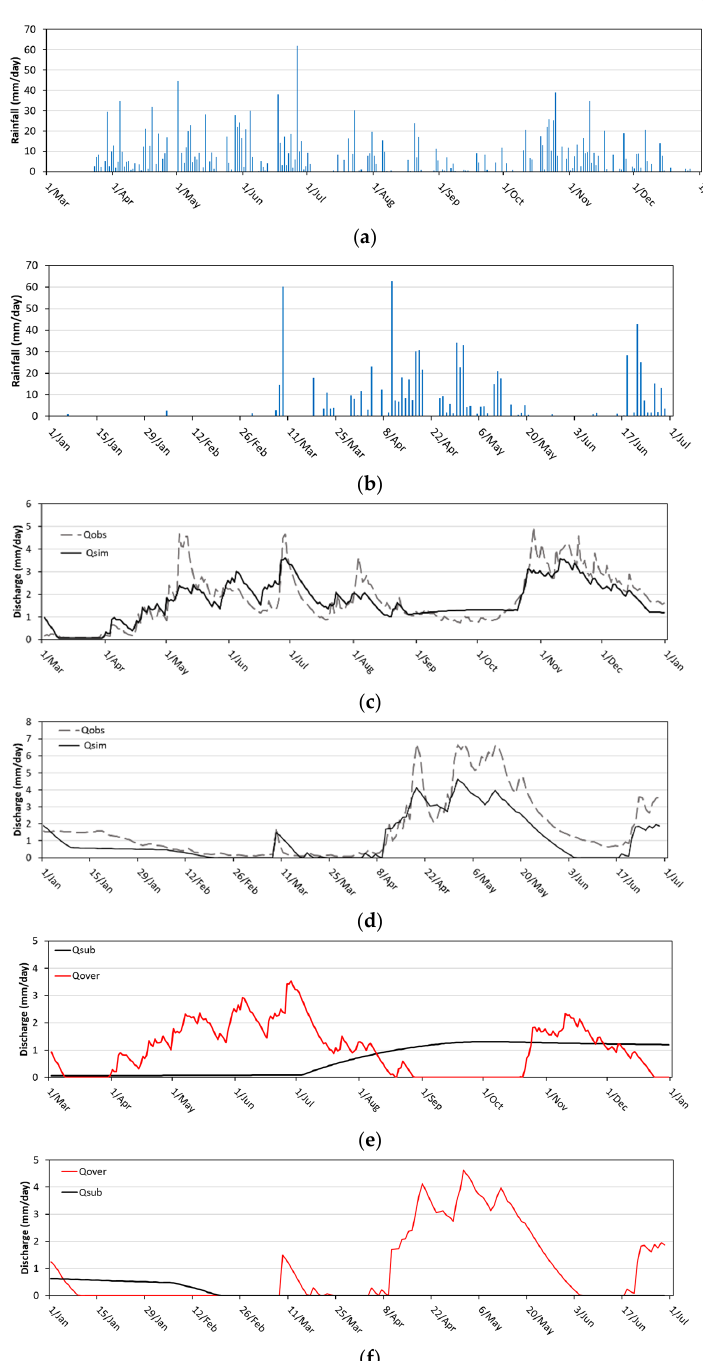
Figure 7. Observed rainfall, observed hydrograph and the hydrographs simulated by tank model. ( a ) Observed rainfall in 2015; ( b ) Observed rainfall in 2016; ( c ) Observed hydrograph and the hydrograph simulated during model calibration in 2015; ( d ) Observed hydrograph and the hydrograph simulated during model validation in 2016; ( e ) Hydrograph separation in 2015 during